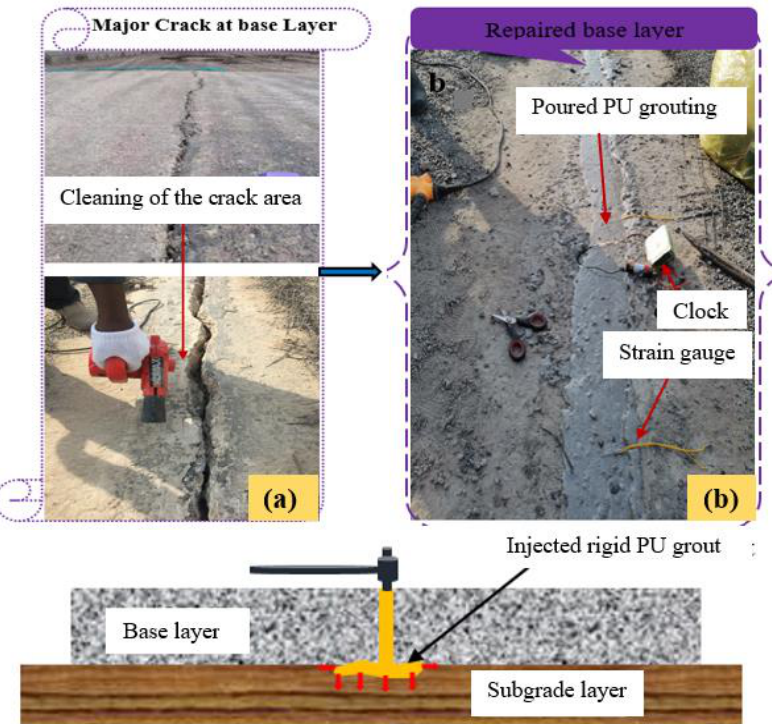
Figure 10. Schematic illustration of highway pavement at base layer repair: ( a ) cleaning the crack portion; ( b ) repairing pavement.